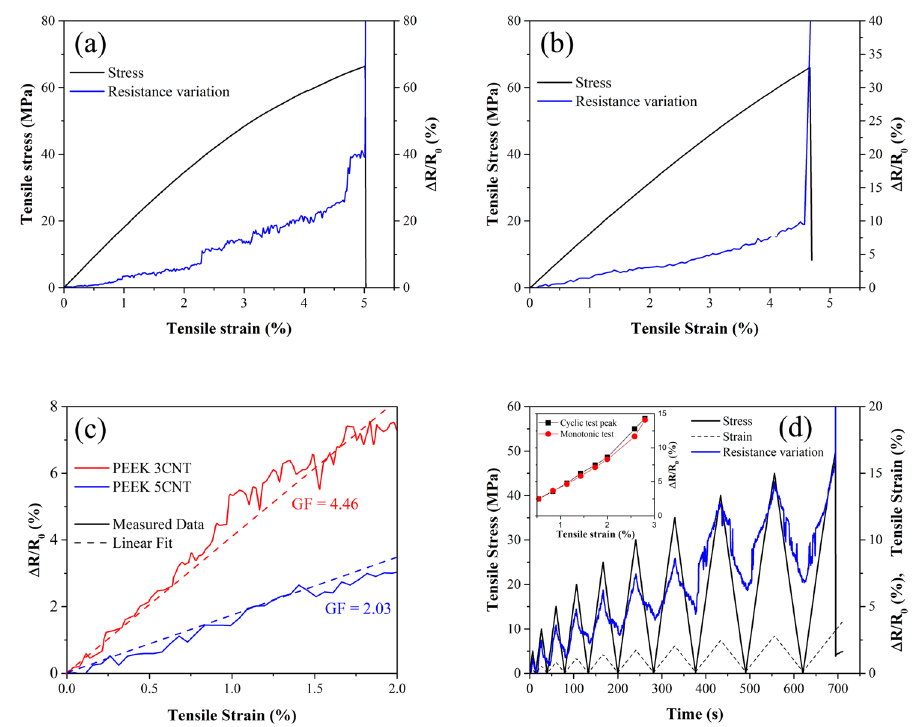
Figure 4. Tensile stress (black line) and electrical resistance (blue line) curves as a function of strain for ( a ) PEEK 3CNT 3D-printed sample and ( b ) PEEK 5CNT 3D-printed sample; ( c ) comparison of the electrical resistance variation with computed gauge factors; ( d ) self-monitoring performances of PEEK 3CNT 3D-printed sample for cyclic loadings; inset: comparison between the maximum values reached in each cycle and the values obtained with monotonic testing.